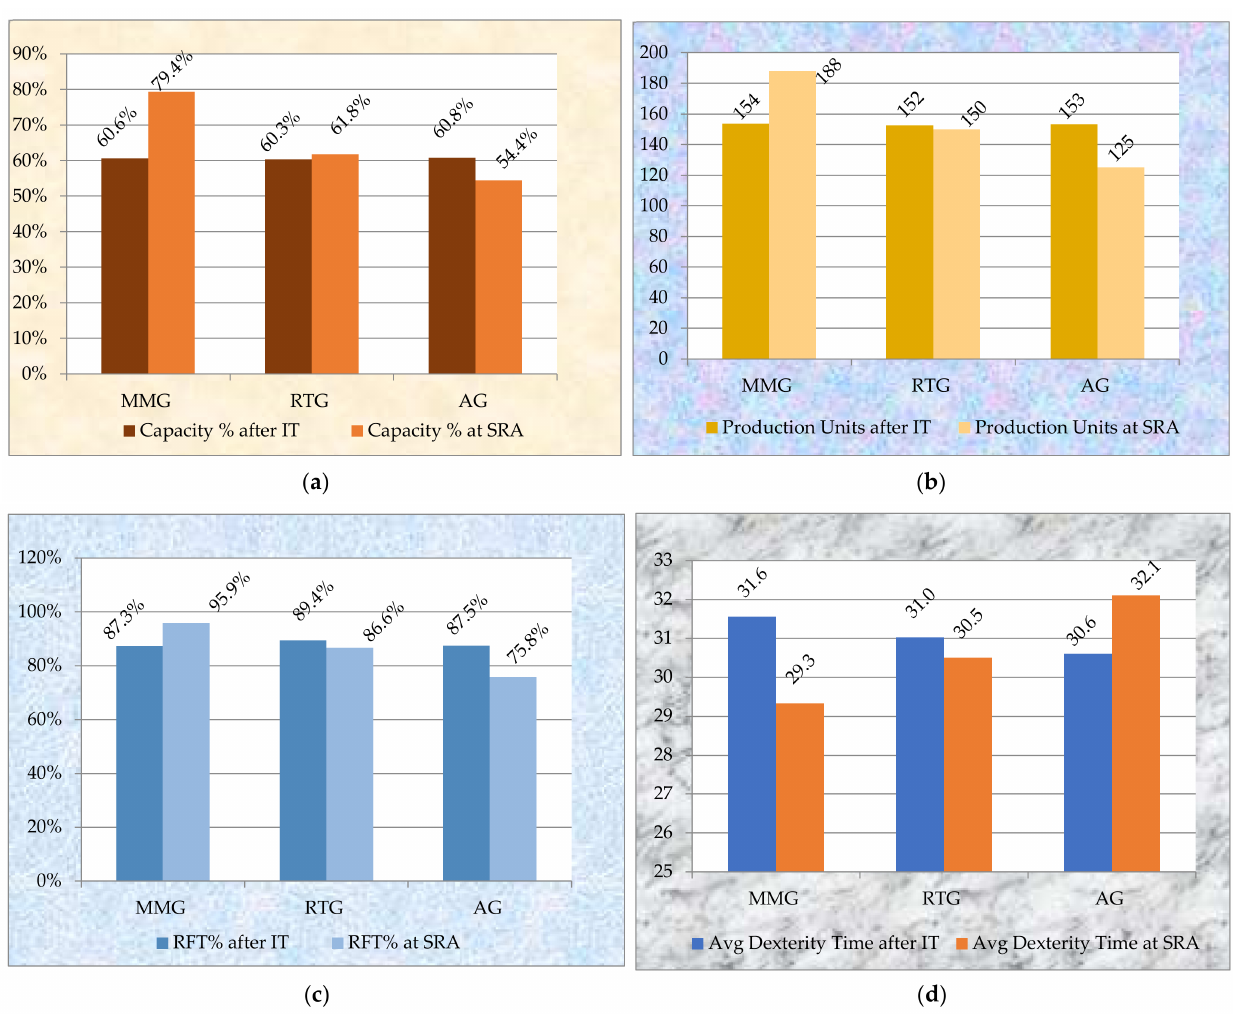
Figure 4. ( a ) Average capacity% of groups after initial training and at the skill retrieval assessment (SRA) phase; ( b ) Average production/day of groups after initial training and at skill retrieval assessment(SRA); ( c ) Average RFT% of groups after initial training and at skill retrieval assessment (SRA); ( d ) Average dexterity score of groups after initial training and at skill retrieval assessment